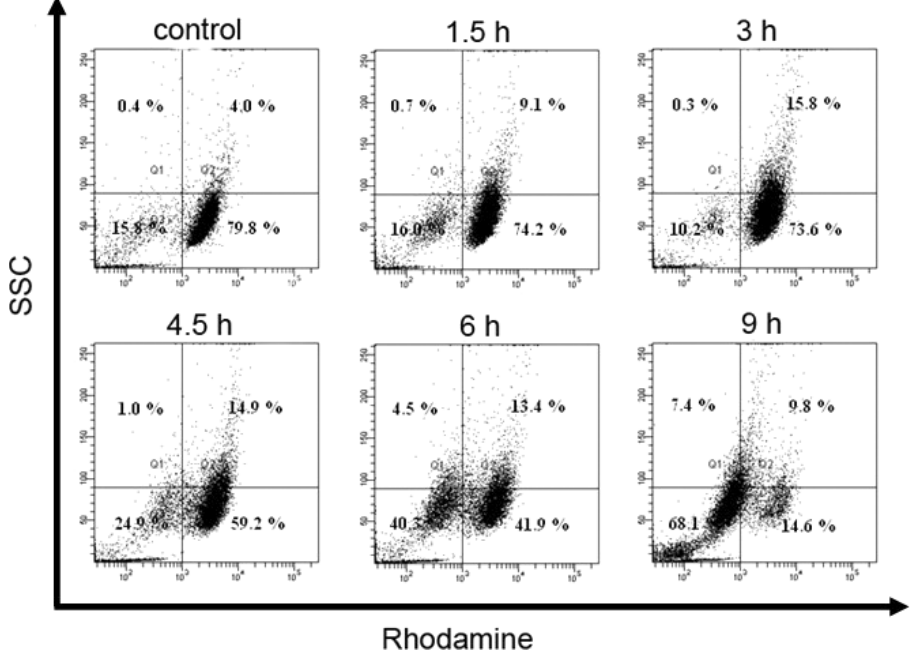
Fig. 1. Taxol-induced cytoplasmic vacuolization precedes the dissipation of (cid:1)(cid:2) m . The cells treated by taxol were stained with Rhodamine 123 for 30 min, and the °uorescence intensity was detected by FCM to analyze the loss of mitochondrial membrane potential ( (cid:1)(cid:2) m